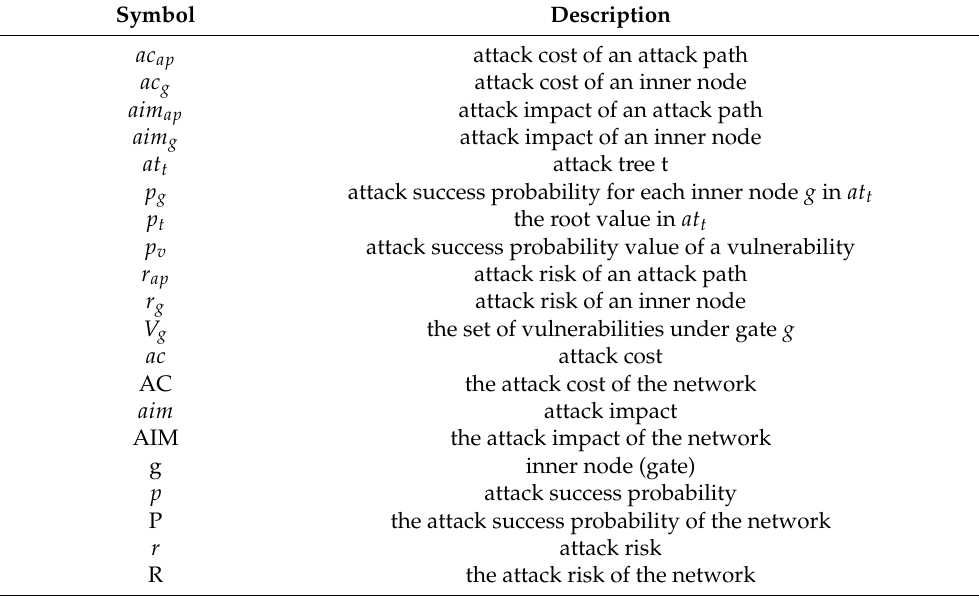
Table 2. List of mathematical symbols in alphabetical